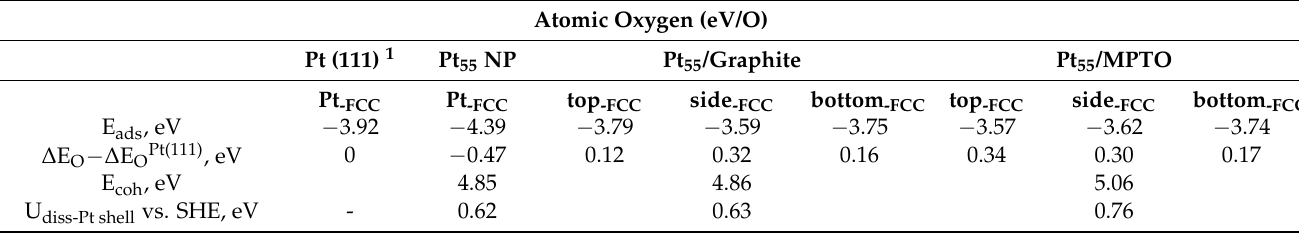
Table 1. The oxygen adsorption strengths, cohesive energies, and dissolution potentials regarding Pt bulk, a Pt nanoparticle, Pt/graphite and